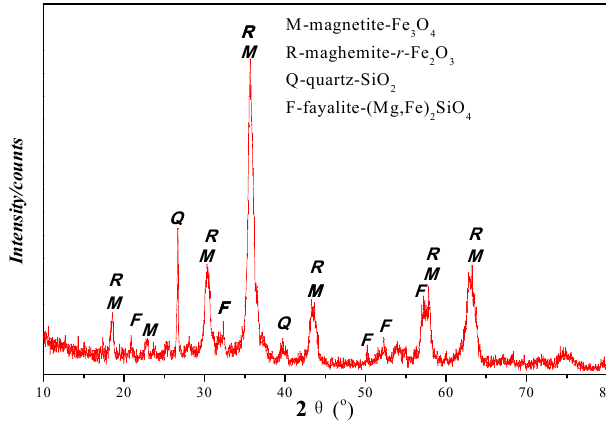
Figure 3. XRD patterns of the nickel slag.